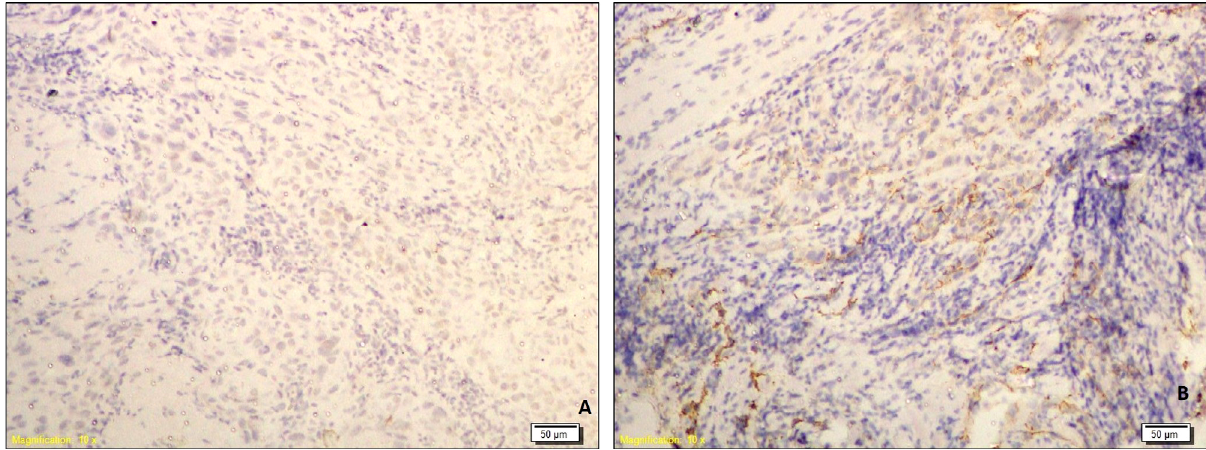
Figure 1- Photomicrograph showing a case of OSCC of Group 1 with low expression of SOX2 (A) and Low expression of podoplanin